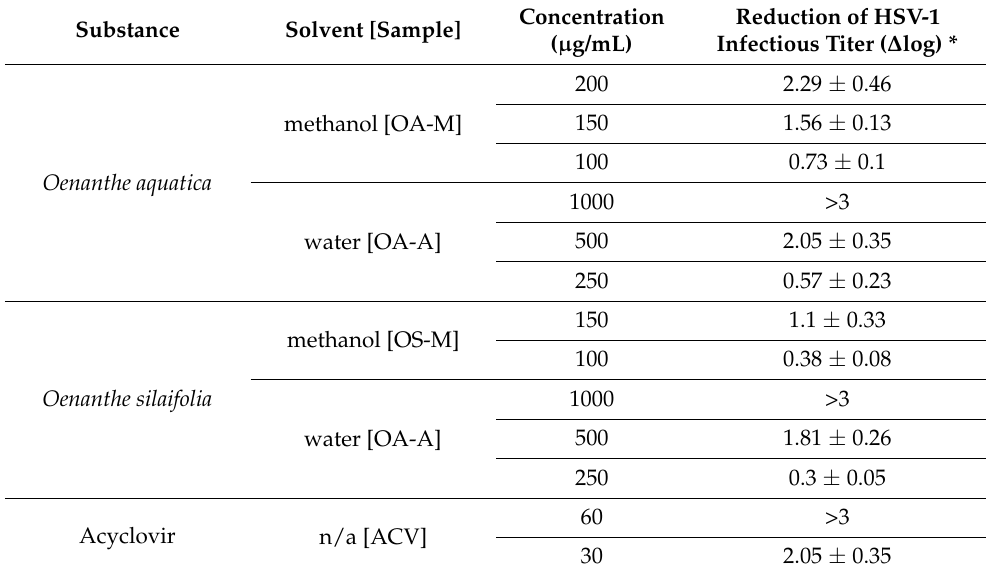
Table 6. Decrease of HSV-1 titer by the O. aquatica and O. silaifolia